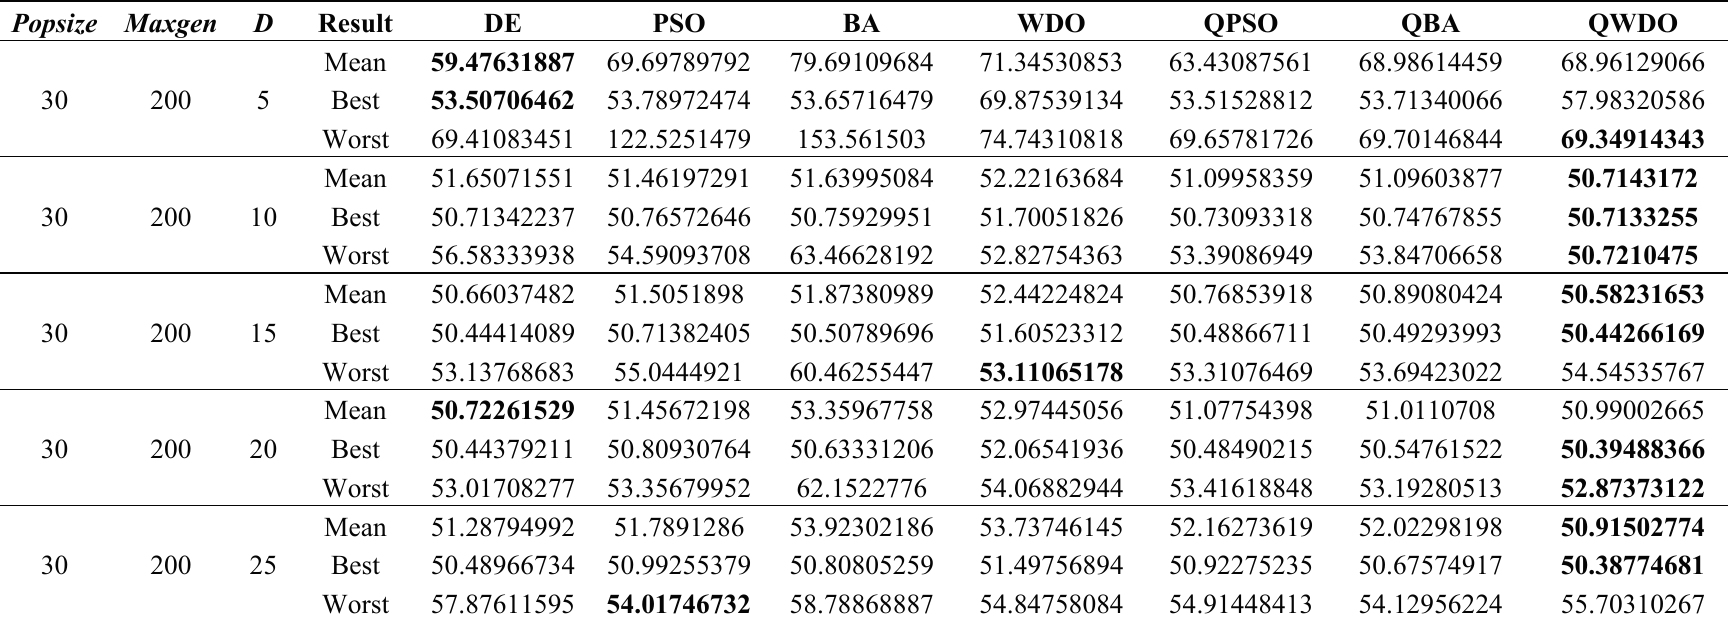
Table 9. Experimental results for the first test instance in different D